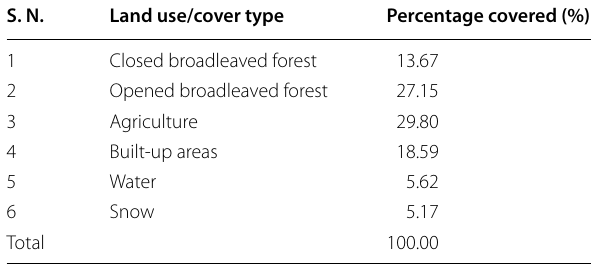
Table 7 Land-cover mapping classes for Kaski–Tanahun districts (2015) S. N.